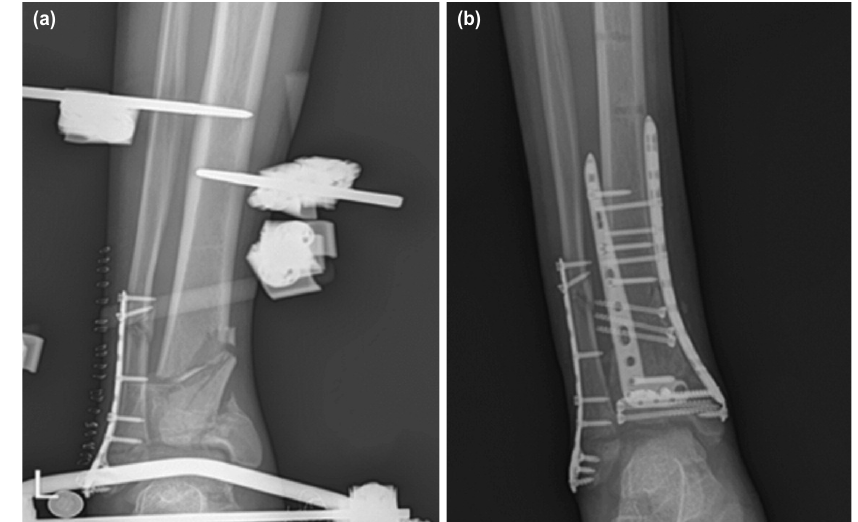
(a) Radiograph images of the patient who underwent fibula fixation in the first stage. Fracture of the fibula was treated with Fig. 1: open reduction internal fixation in the first stage. (b) Definitive treatment was applied to the fracture of the tibia after soft tissue swelling resolves.